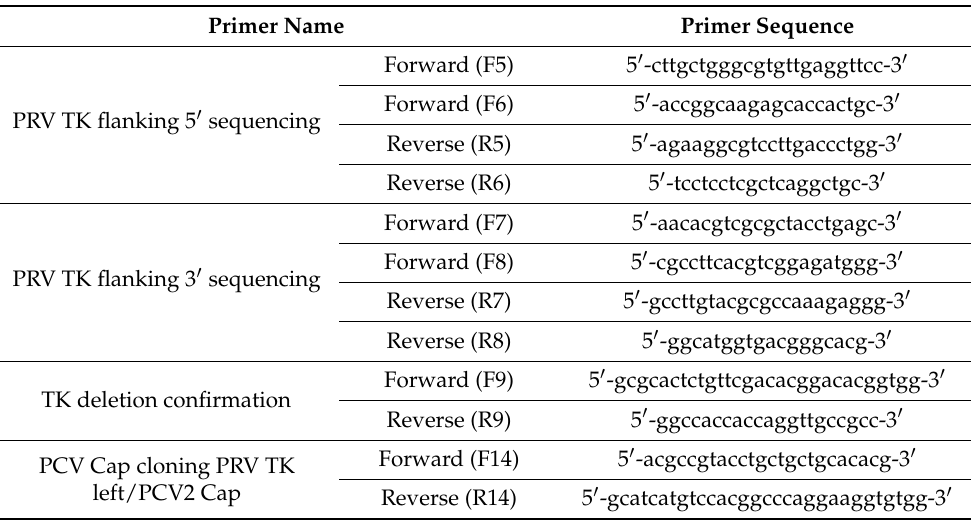
Table 2. List of primers used to verify the PRV TK-deletion and PCV2 Cap chimeric gene-insertion by PCR and/or